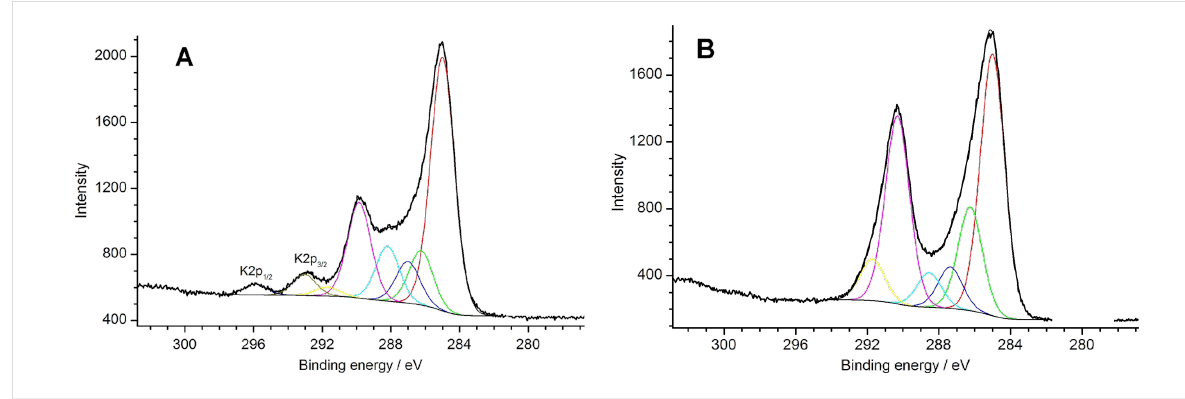
Figure 3: XPS spectra of C 1s of the LNM/C composite samples derived from the linear (A) and cross-linked (B) PVA.